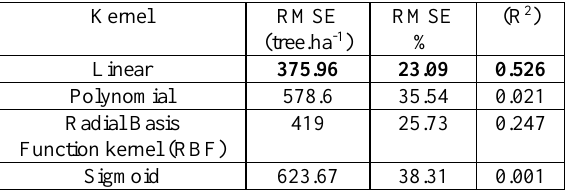
Table 4. The results of SVR algorithm with different kernels for estimating TD Kernel